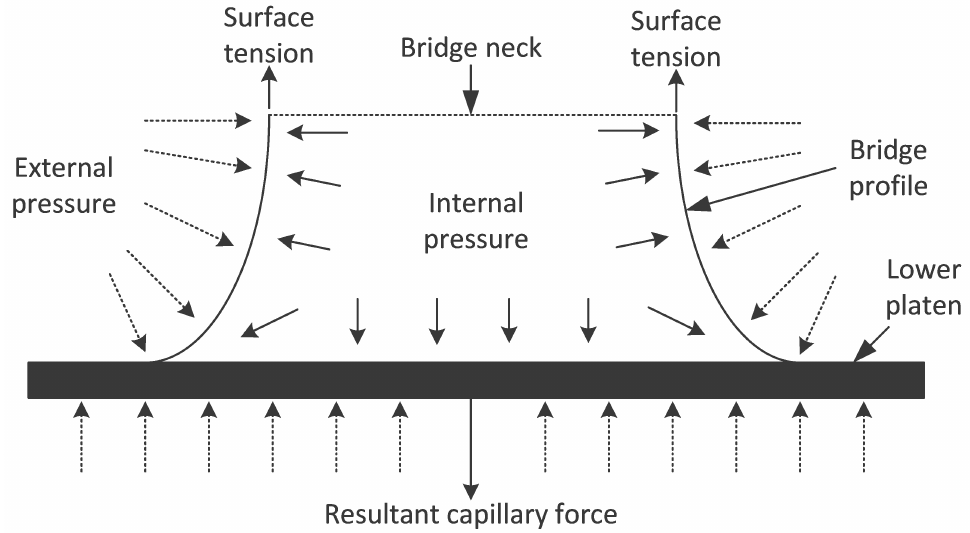
Figure 2. Schematic of the lower half of the liquid bridge denoting the various pressure and forces that result in the measured capillary force.